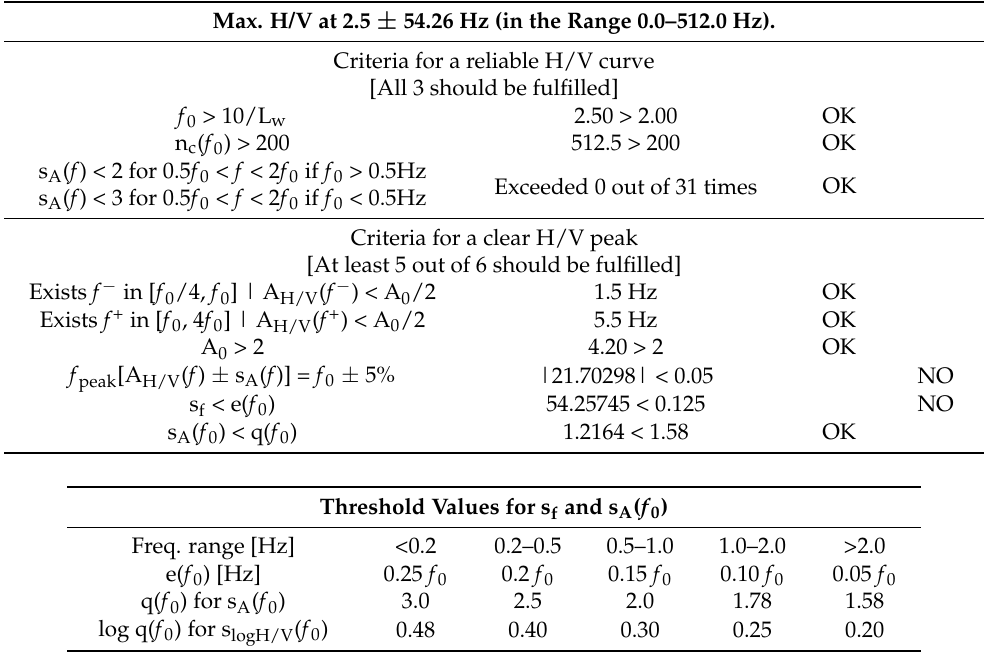
Table A1. Reliability of H/V curve and clarity of H/V peak recorded at the seaward side of the